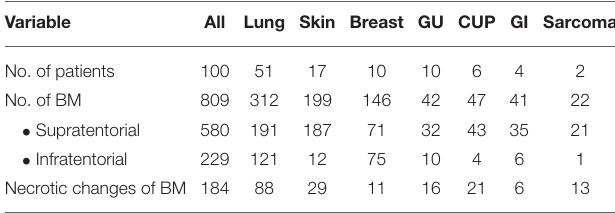
TABLE 2 | BM characteristics among the whole cohort and the different primaries.